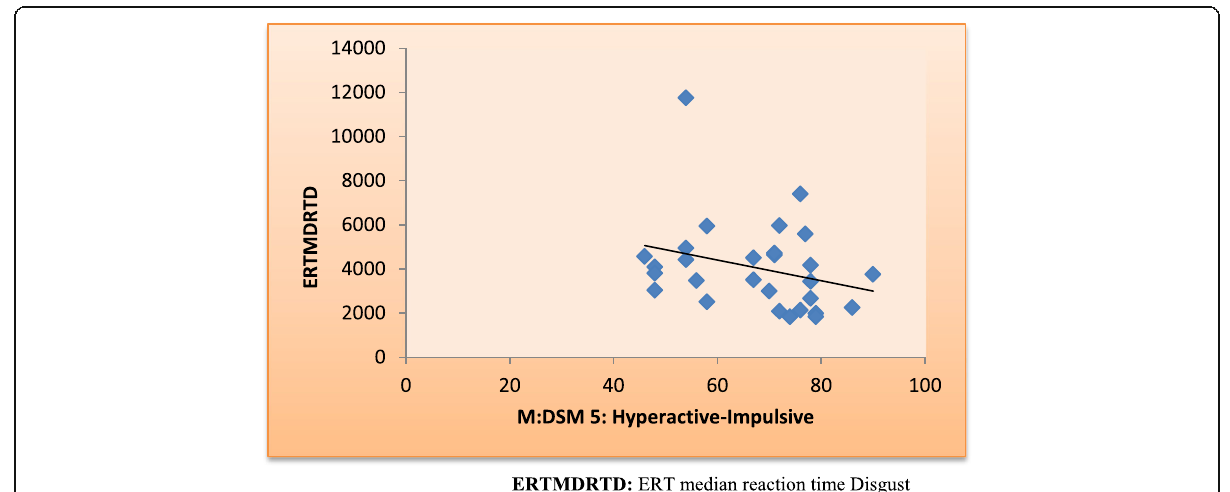
Fig. 2 Scatter chart showing negative correlation between ERTMDRTD and ADHD hyperactive impulsive subtype